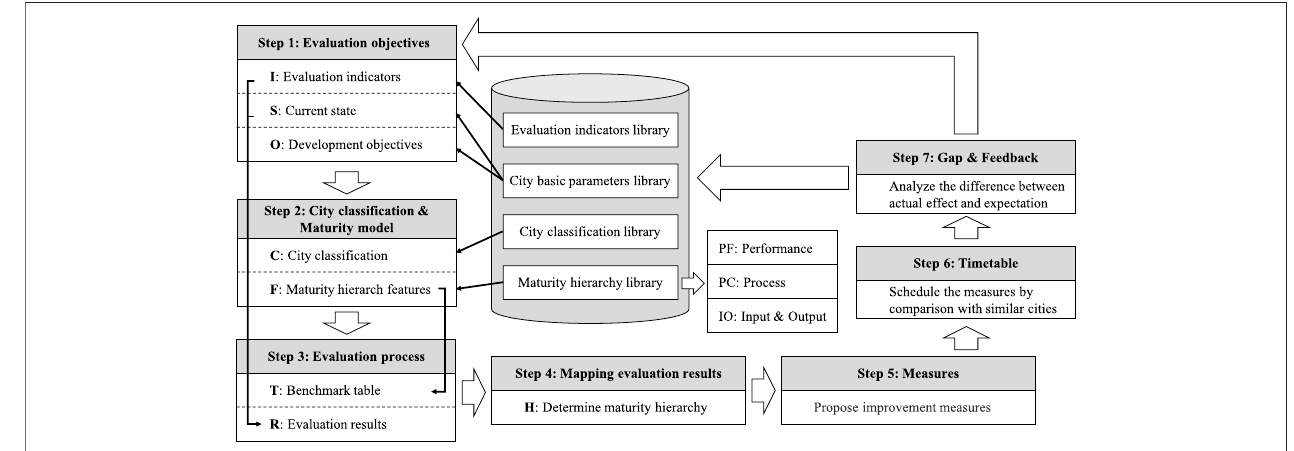
FIGURE 3 | The framework of the Maturity Model-based Service Evaluation (MMSE) for smart city services.